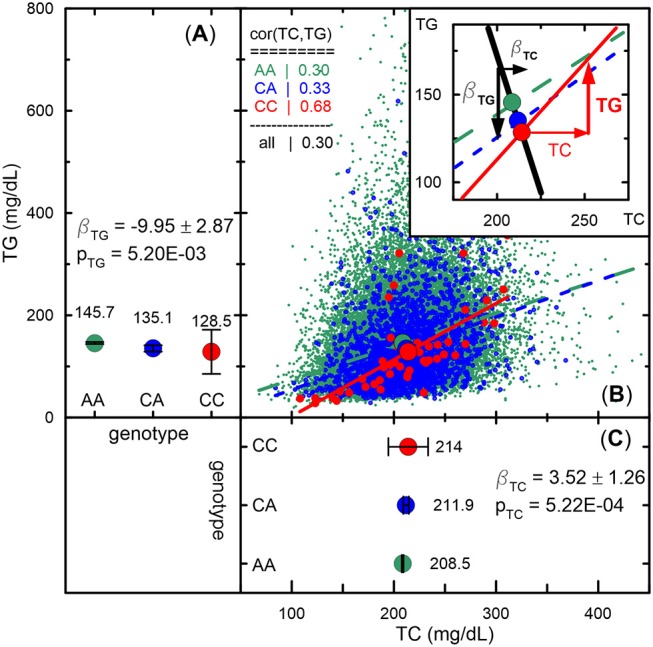
Empirical illustration of antagonistic genetic heterogeneity. (A,C) Mean values and 95% confidence intervals of TG and TC, respectively, for rs1801689 genotypes (green for AA, blue for CA, and red for CC) in the Atherosclerosis Risk in Communities Study measured at baseline. Beta and p denote effect sizes and p-values, respectively. Antagonistic genetic heterogeneity is evidenced by opposite directions of changes in mean values across genotypes for directly correlated phenotypes (i.e., a minor allele associated with a larger concentration of TC is associated with a smaller concentration of TG, whereas a larger concentration of TC correlates [r = 0.68 for CC genotype] with a larger concentration of TG for this allele). (B) Scatter plot of TG vs. TC. The slopes of lines represent correlation coefficients given in the upper left corner inset. The upper right corner inset illustrates antagonistic genetic heterogeneity by showing opposite directions of genetic effect for TG (black line) and projection of the vector of the correlation on TG (red line). See other details in see “Materials and Methods” section and Figure 2.